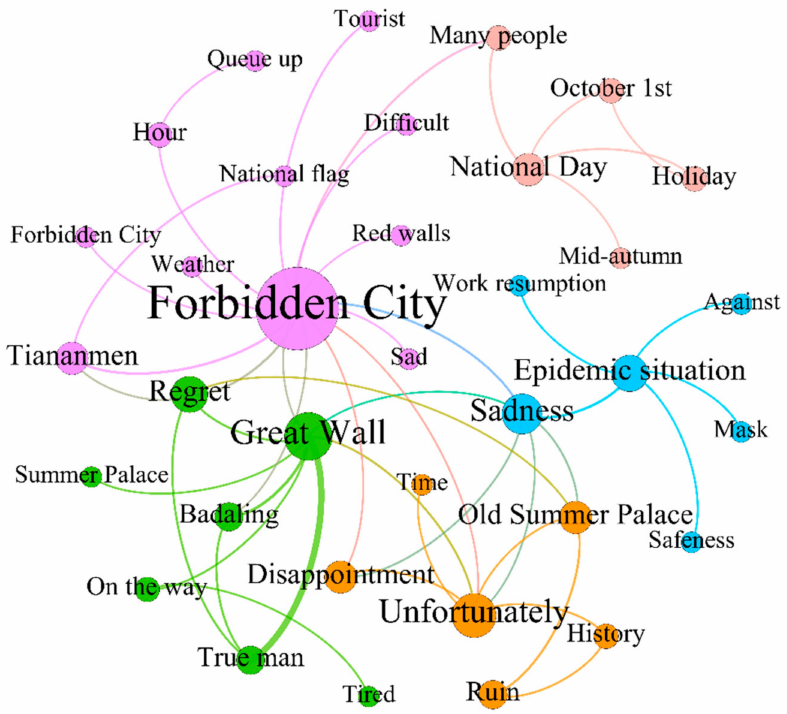
Figure A2. The negative sentiment profile of tourist flows linked to attractions in the daytime.